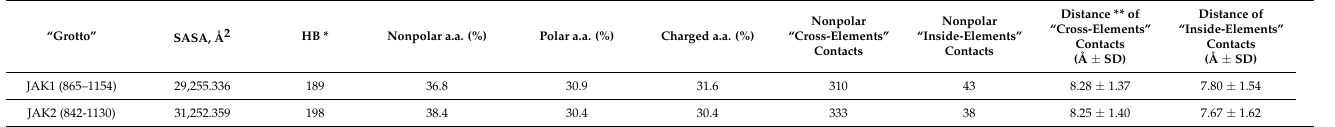
HB *—number of hydrogen bonds; distance **—between nonpolar